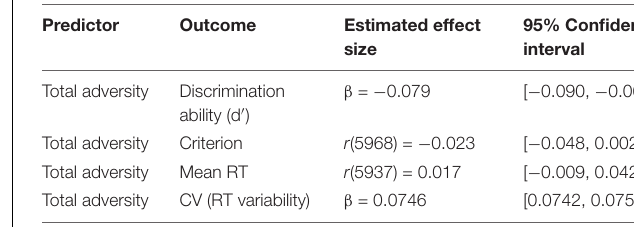
TABLE 2 | Effect sizes and confidence intervals for all reported regressions and